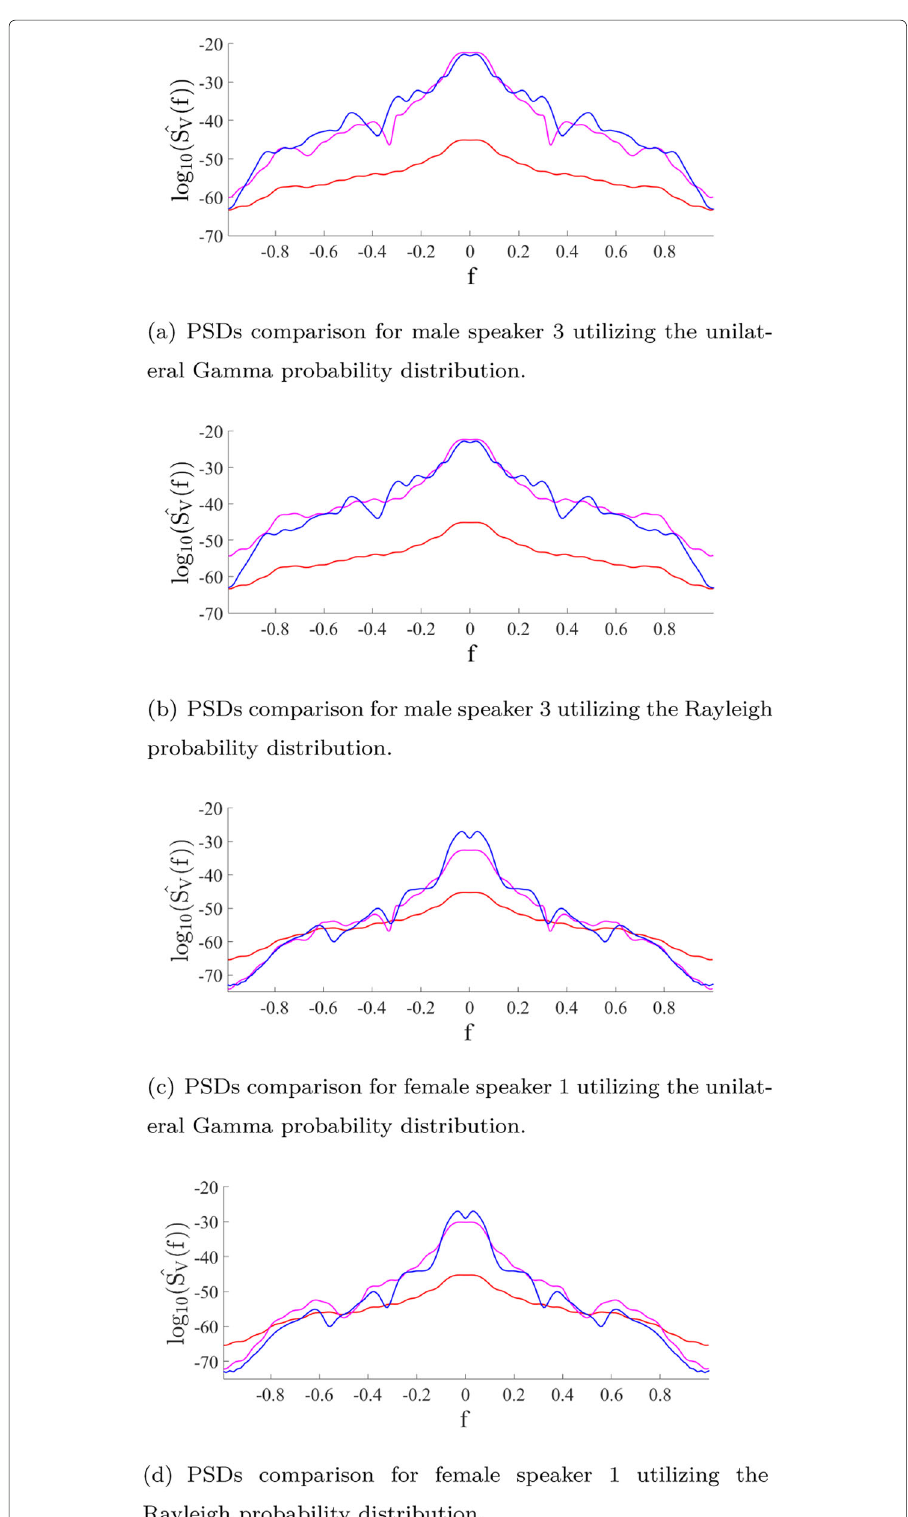
Fig. 14 Power spectral densities curves, as a function of the frequency f ( × π rad / s ) , for male and female speakers: new voice generation model (lilac), classic source-filter (red) and estimated by voice locution